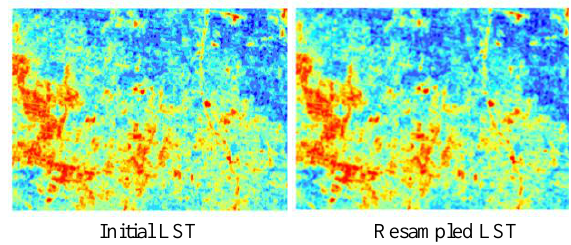
Figure 4. Landsat7 initial and resampled LST inversion data